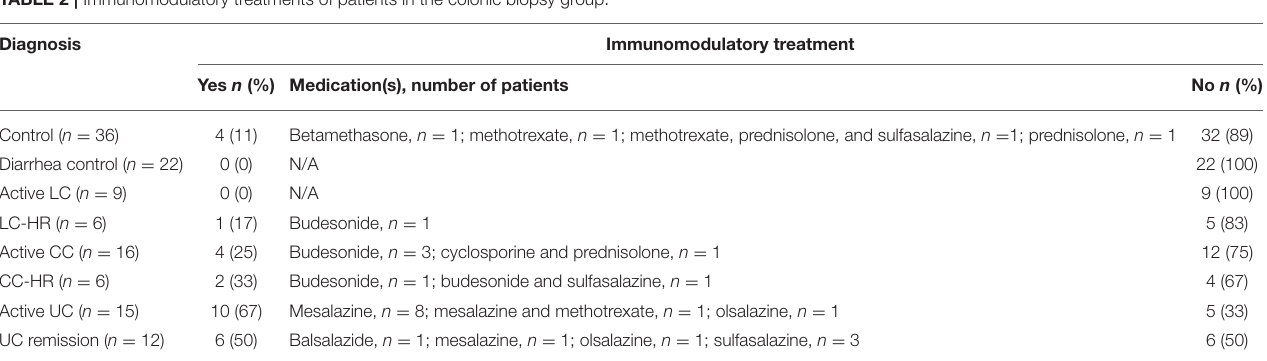
TABLE 2 | Immunomodulatory treatments of patients in the colonic biopsy group. Diagnosis Immunomodulatory